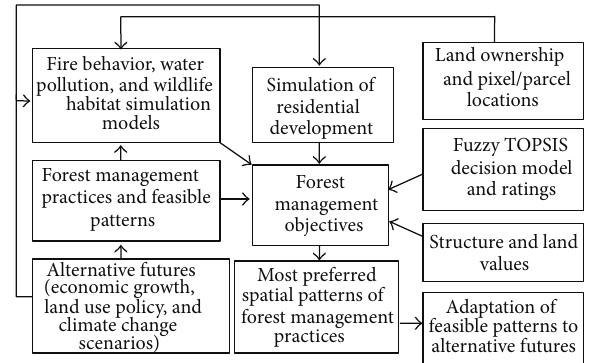
Figure 1: Flow diagram of proposed conceptual